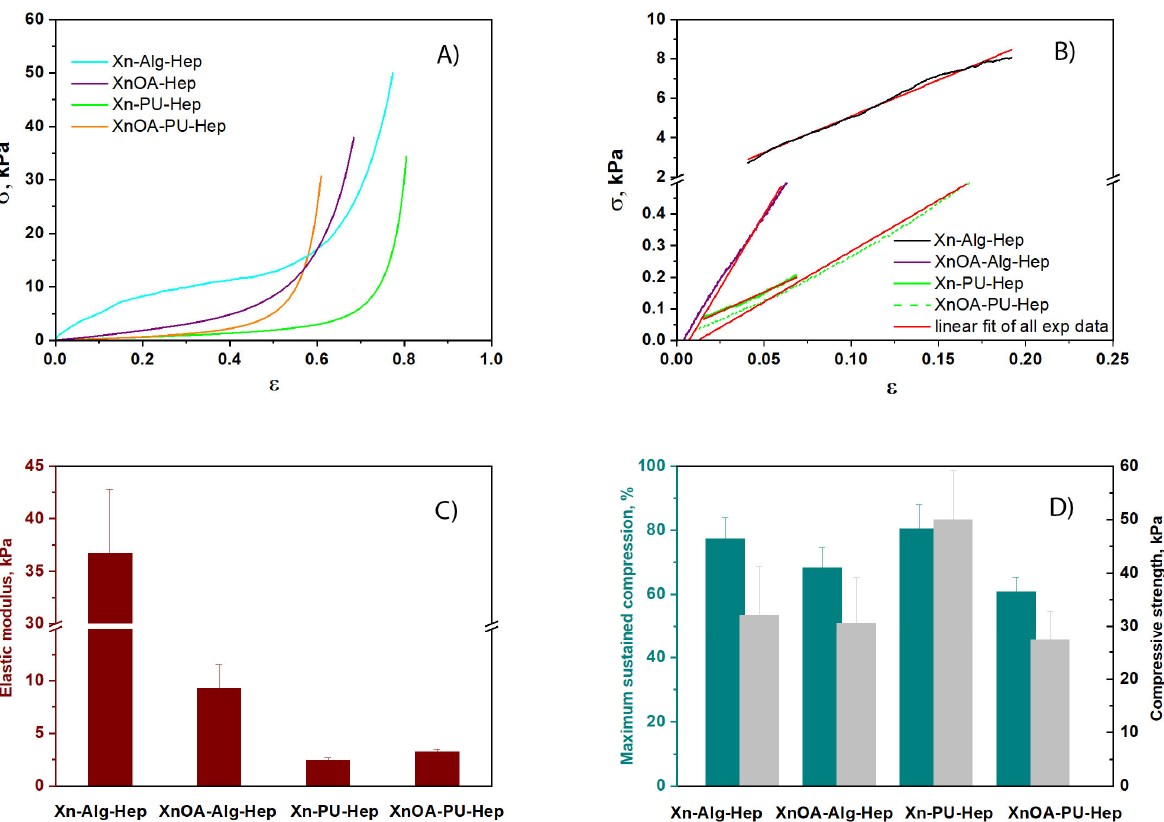
Figure 2. The mechanical properties of swollen Hep-loaded formulations under compression: ( A ) stress–strain profiles of Hep-loaded formulations; ( B ) linear dependence of stress–strain curves; ( C ) elastic modulus (wine color) determined according to the standard method; ( D ) maximum sustained compression (dark cyan color) and compressive strength (light grey color). The standard deviations are presented as error